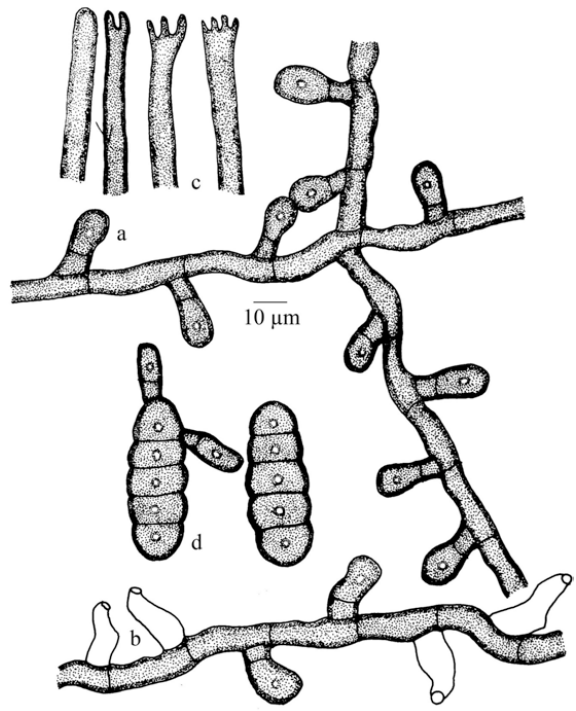
Figure 16. Meliola savarkarii sp. nov. a - Appressorium, b - Phialide, c - Apical portion of the mycelial setae;